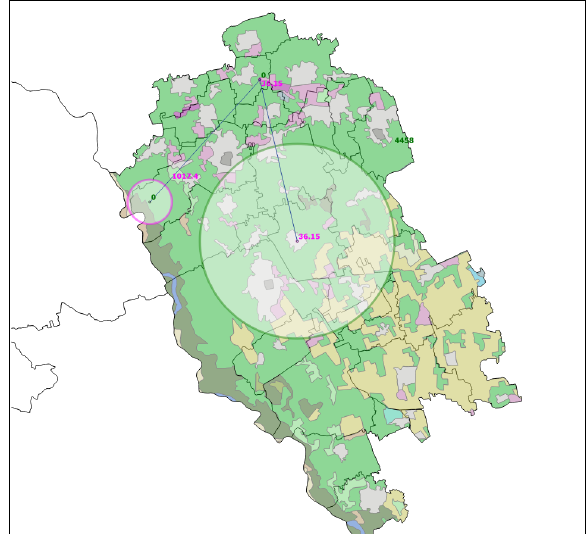
Figure 12. Same IG presented in Figure 11, in the background, map of land use types (biomass availability among Resources Geographies).